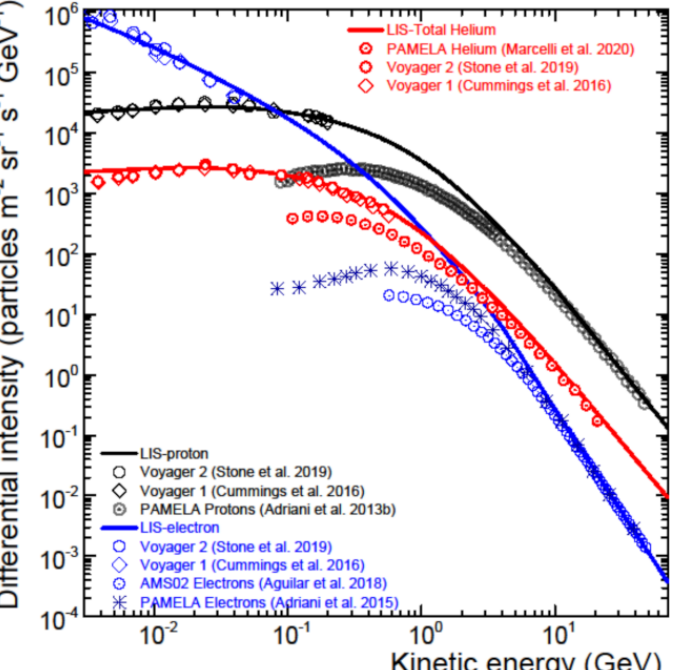
Figure 6. The very local interstellar spectra (VLISs) at the heliopause (HP) (122 AU) for galactic protons (black line), electrons (blue line) and total helium (red lines) with observations at the HP from Voyager 1 [19] and Voyager 2 [7], and corresponding spectra at the Earth from AMS-02 [5] and PAMELA